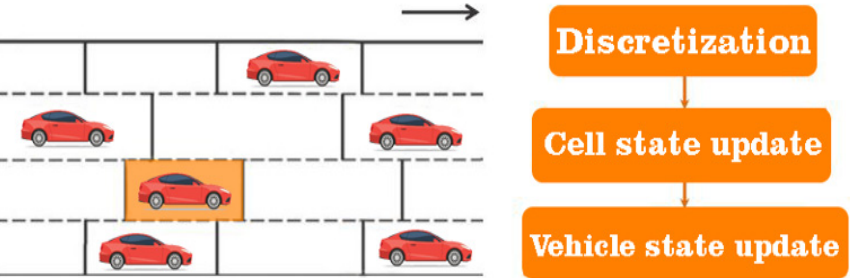
Figure 9. Illustration regarding the macroscopic analysis standard in relation to traffic on separate lanes and cells. Identification of each state in the updated cell through parameterized solutions.